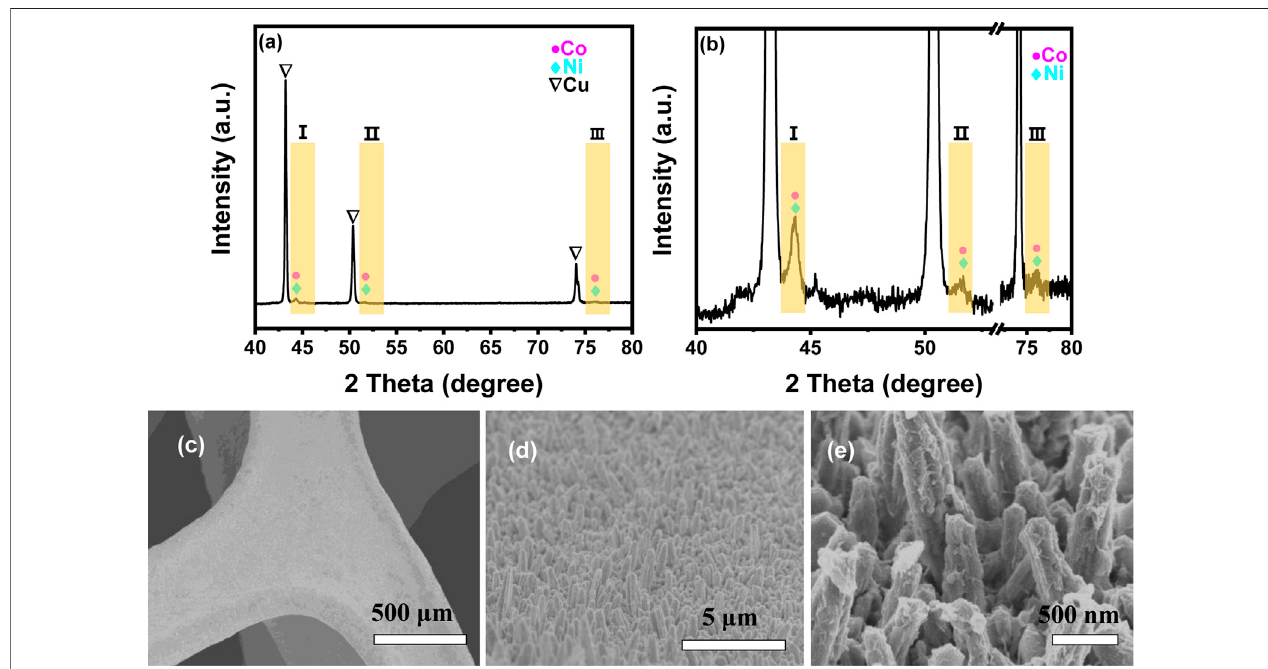
FIGURE 8 | XRD pattern (A) , magni fi ed XRD pattern (B) , and SEM images (C – E) of NiCo-1/CF after catalytic